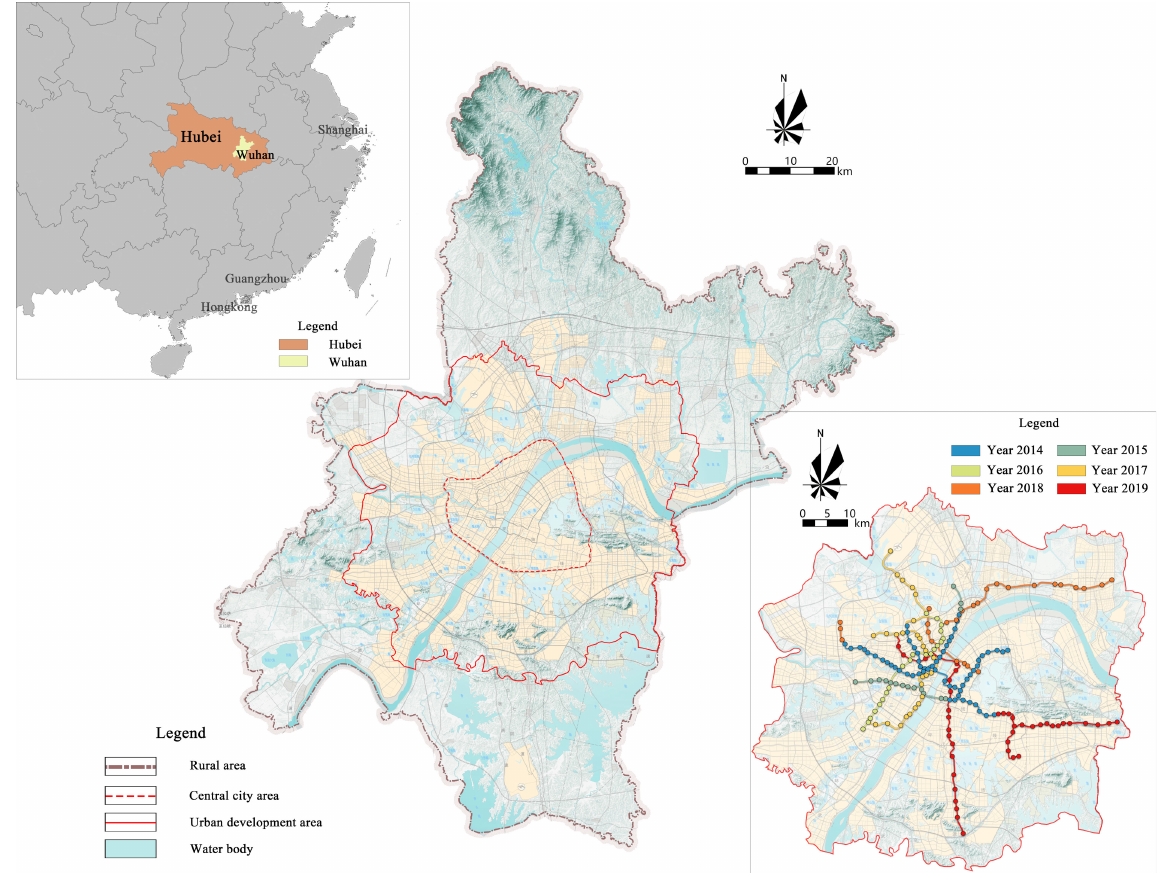
Figure 1. Study area and spatiotemporal expansion of rail transit network. Note: By March 2019, Xujiapeng Station of Line 8 and Xujiapeng Station of Line 7 have not yet opened for interchange, so this article is calculated separately by two stations.